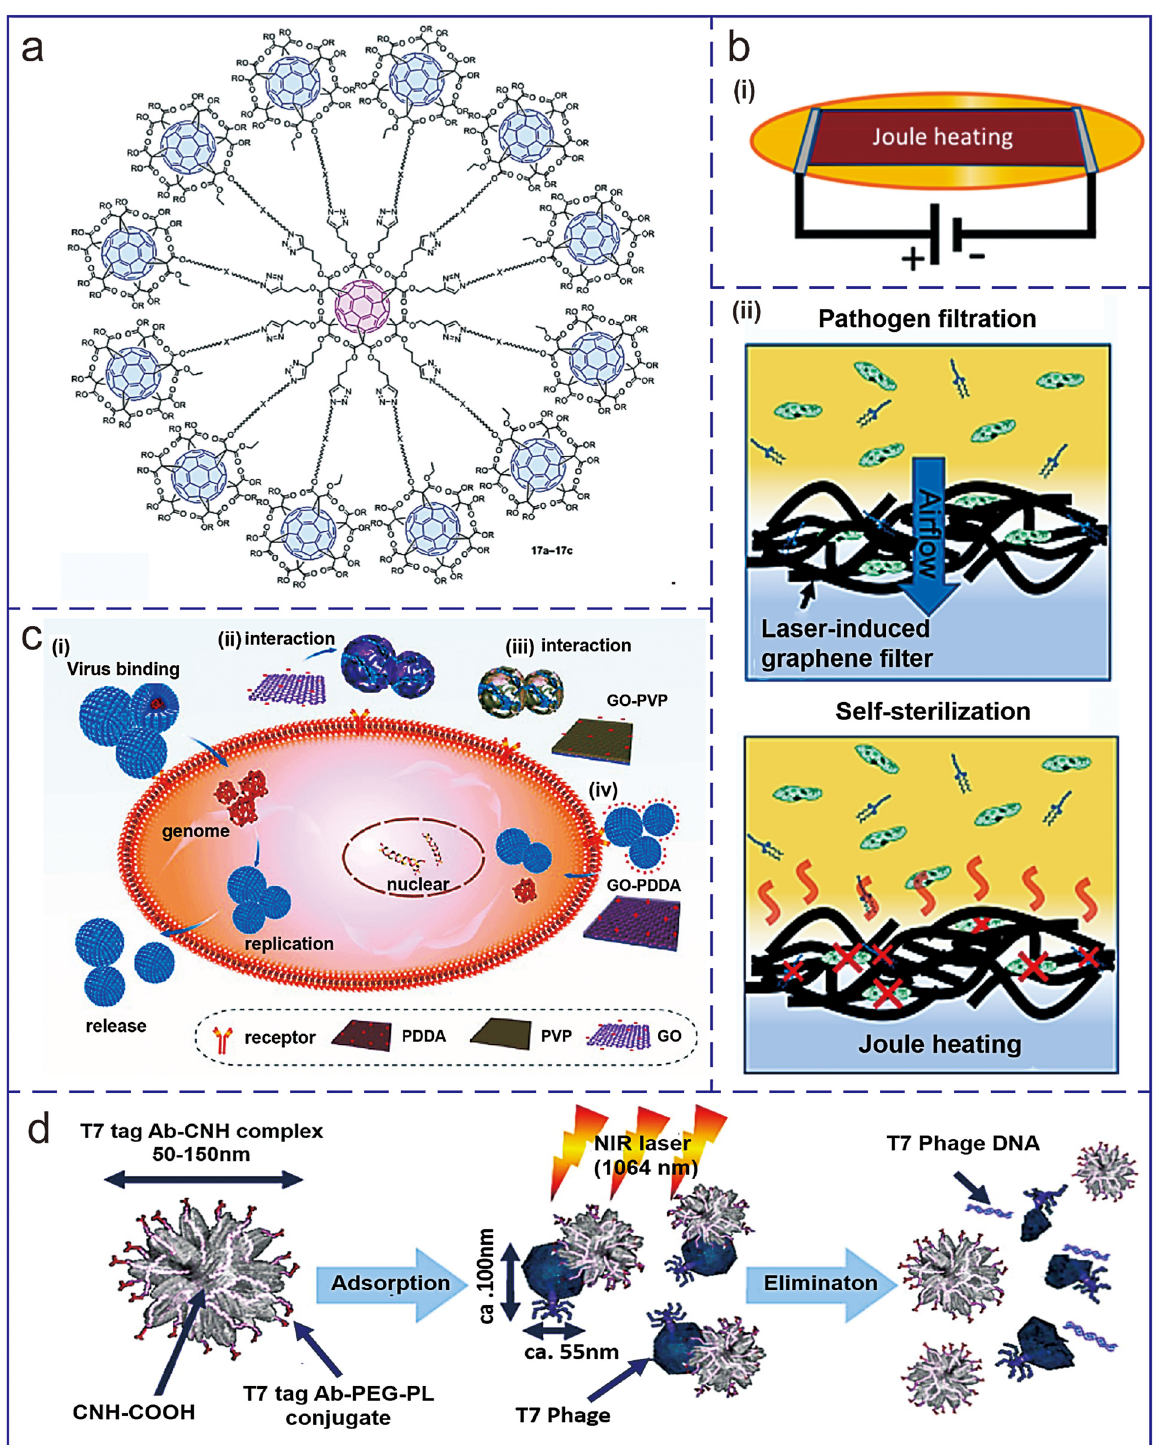
Figure 4: Antiviral mechanism of carbon - based materials. ( a ) Structure of the tridecafullerenes 17a – 17c, the central C60 core is covalently connected to 12 hexakis adducts of C60. Each peripheral fullerene is endowed with ten monosaccharides and so a total of 120 carbohy - drates decorate the periphery of each molecule [ 41 ] . ( b ) Schematic of bacteria capture, along with subsequent sterilization and depyr - ogenation by Joule - heating. ( i ) Schematic of the Joule - heating setup in which a potential is applied across the fi lter for Joule heating. ( ii ) Schematic of fi ltration followed by sterilization and depyrogenation through Joule heating [ 42 ] . ( c ) Possible mechanisms of the antiviral activity of GO. ( i ) Normal viruses are absorbed into cells by interacting with cell receptors to initiate infection. ( ii ) Negatively charged GO has more chances to interact with the positively charged viruses, resulting in virus damage and infection suppression. ( iii ) Infection was blocked by GO conjugated with nonionic PVP. ( iv ) Conjugation of GO with cationic PDDA cannot prevent the virus from infecting cells [ 47 ] . ( d ) Method for the elimination of a virus by using CNH complexes and NIR laser irradiation [ 48 ]